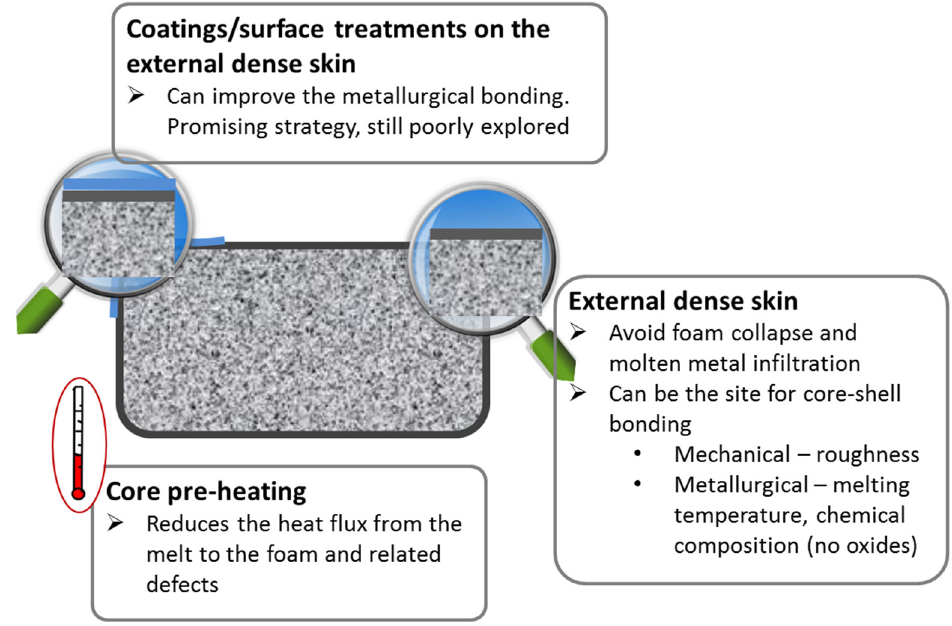
Figure 2. Critical factors for the selection / preparation of Al-based foam cores to be used in casting.